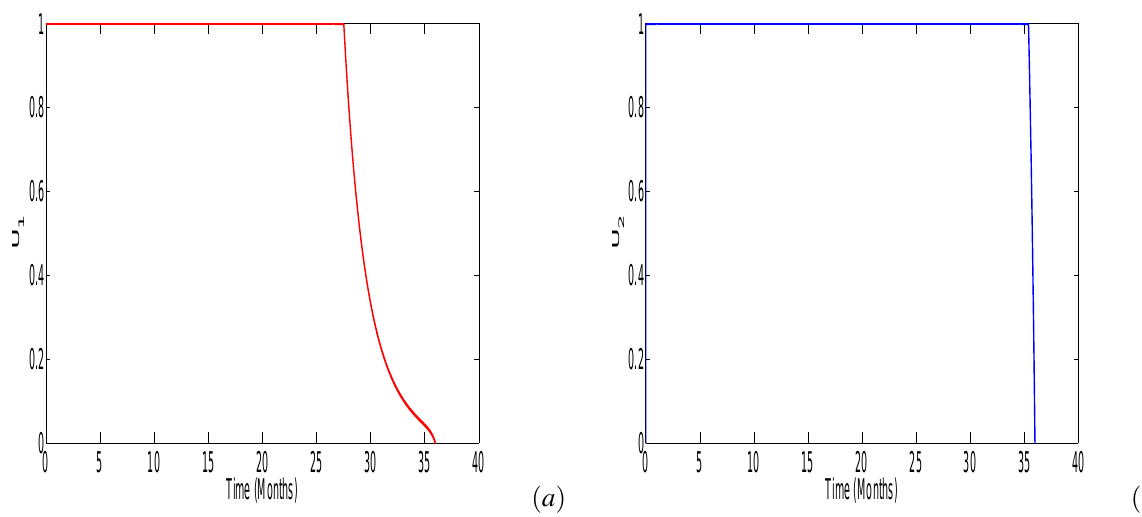
Fig. 4 The optimal control graphs for the two controls, namely, monitoring and counselling individuals infected with HSV-2 only ( u 1 ) and monitoring and counselling individuals dually infected with HSV-2 and HIV ( u 2 ) , over a period of 36